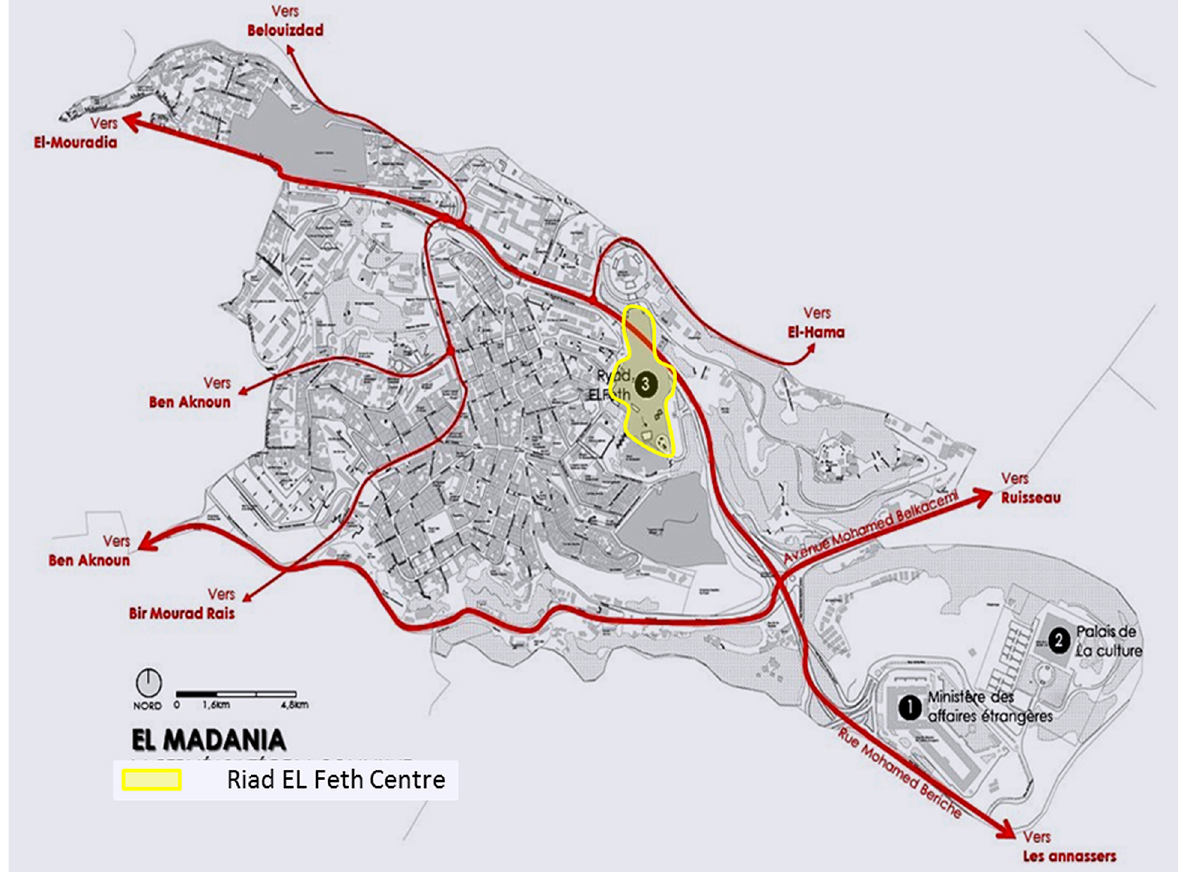
Fig. 4. Location of Riad El Feth. Population Commercial % of small wealth ratio density activity rate apartments